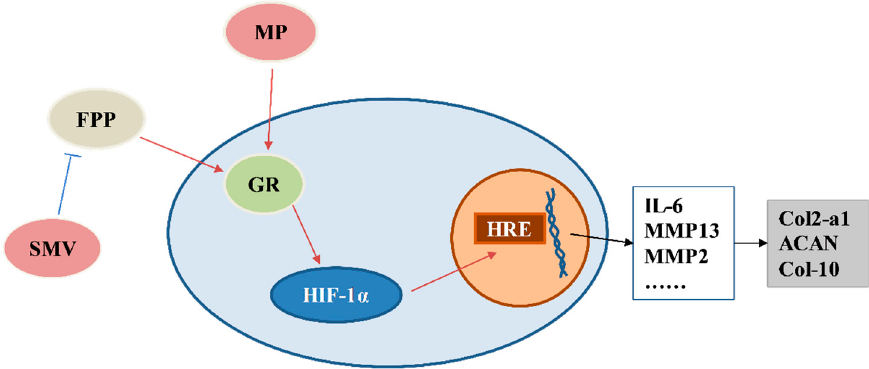
Figure 10. A graphic molecular mechanism of MP-treatment to regulate chondrocyte ECM metabo- lism.